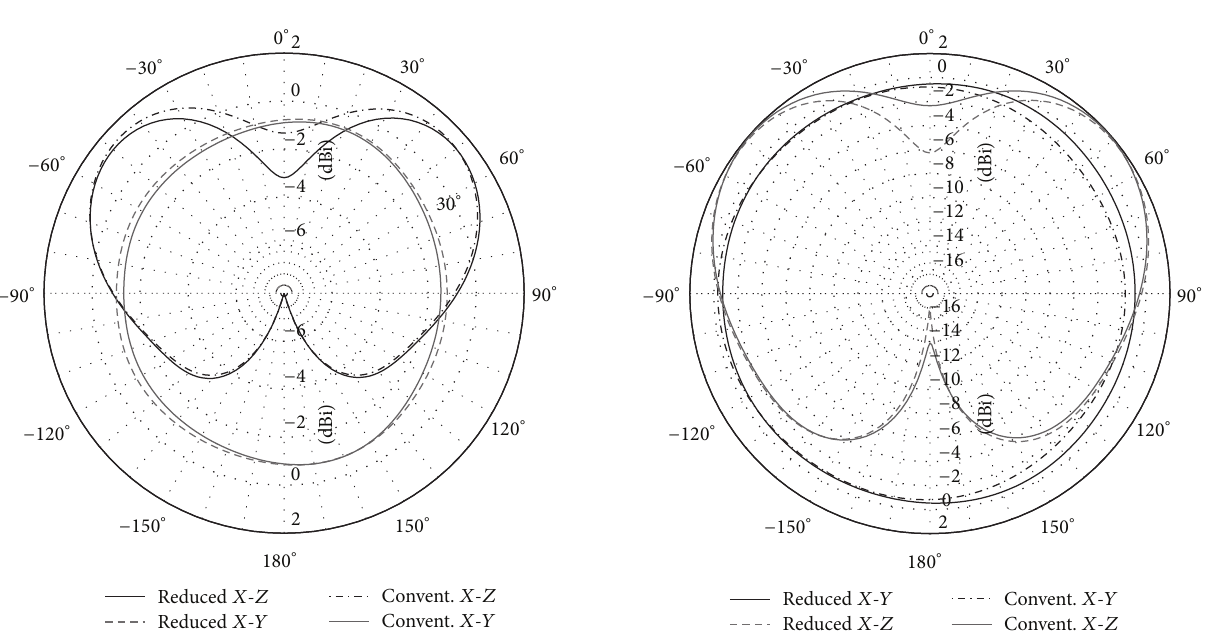
Figure 9: Simulated radiation pattern of reduced and conventional IFA.